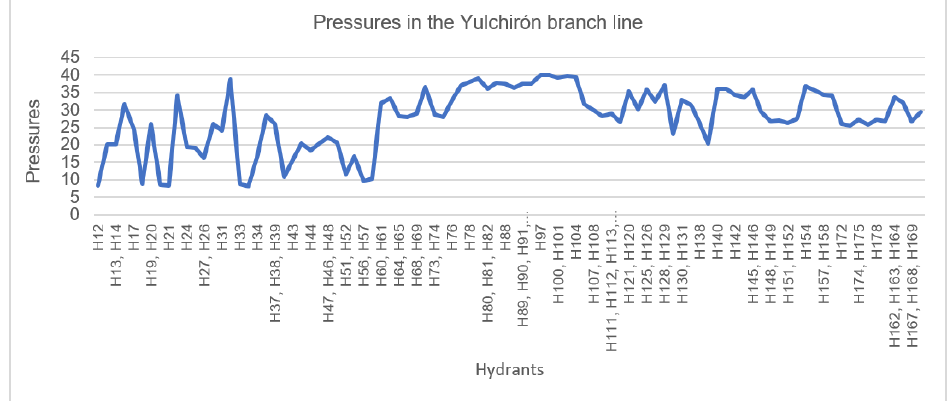
Figure 9. Pressure results, on the Yulchirón 2 branch operating at demand. The operating hydrant pressures for each shift obtained from the hydraulic design are shown in Figure 10. The minimum pressures for shifts one to five are: 11.53, 19.43, 19.45, 19.37, 19.37 mwc and the corresponding pressures are: 54.12, 48.88, 44.89, 48.06, 47.09 mwc, this at the nodes of known demand that are in the open shift. It can be seen that only shift one (T1) does not comply with the minimum design pressure (set pressure) of 17.6 mwc.